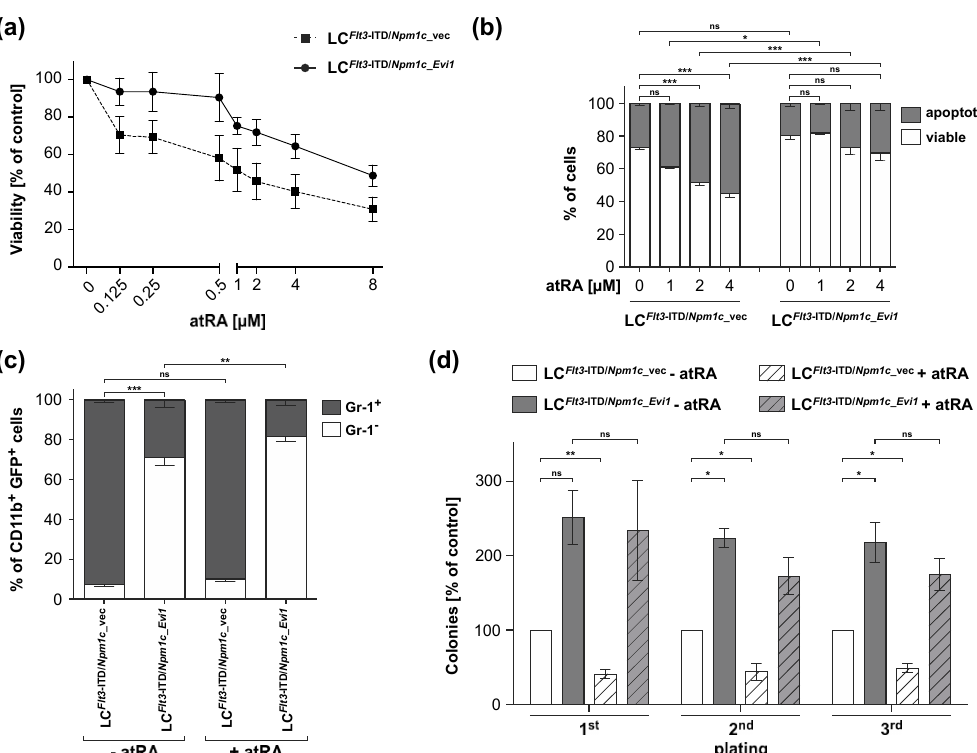
Figure 2. Experimental expression of Evi1 counteracts the anti-leukemic and stem cell inhibitory e ff ects of atRA in Flt3 -ITD / Npm1c -driven murine AML. ( a , b ) Bone marrow LC Flt3 -ITD / Npm1c _vec and LC Flt3 -ITD / Npm1c_Evi1 were treated with the indicated concentrations of atRA or with solvent for 48